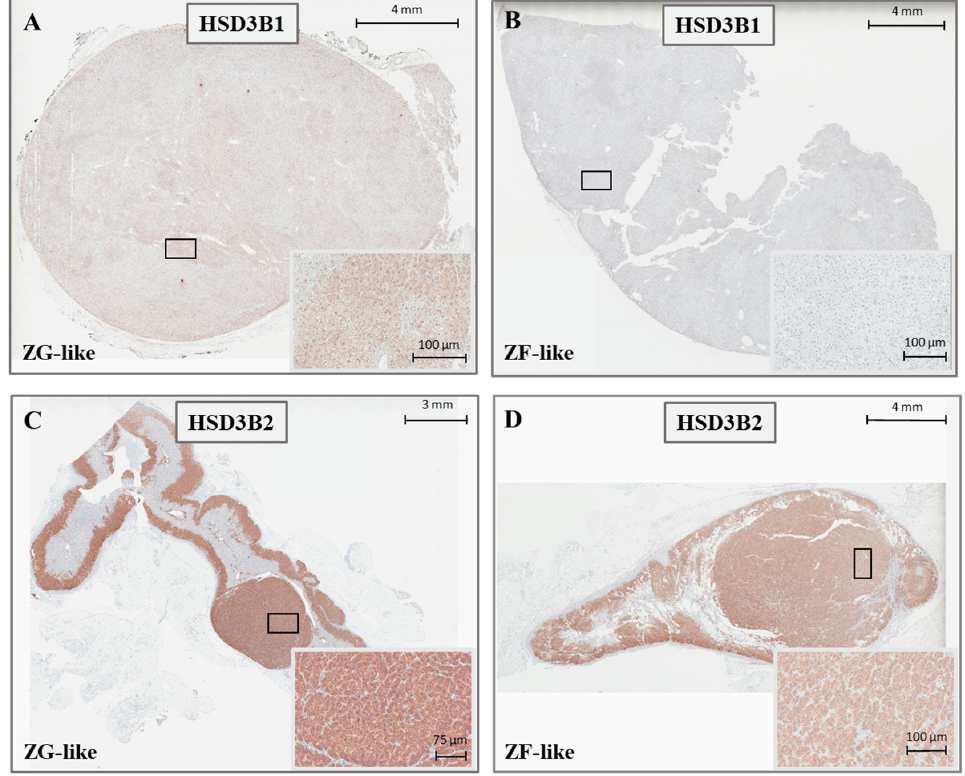
Figure 3. Representative immunohistochemistry staining for HSD3B1 ( A , B ) and HSD3B2 ( C , D ) in APAs, according to the cellular composition.